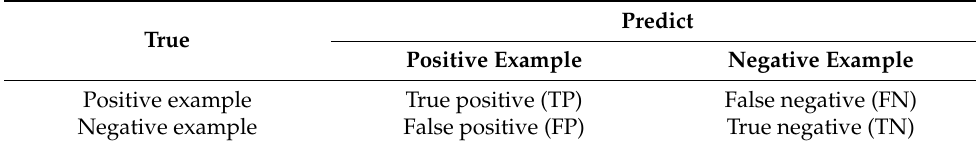
Table 1. A typical binary classification confusion matrix.